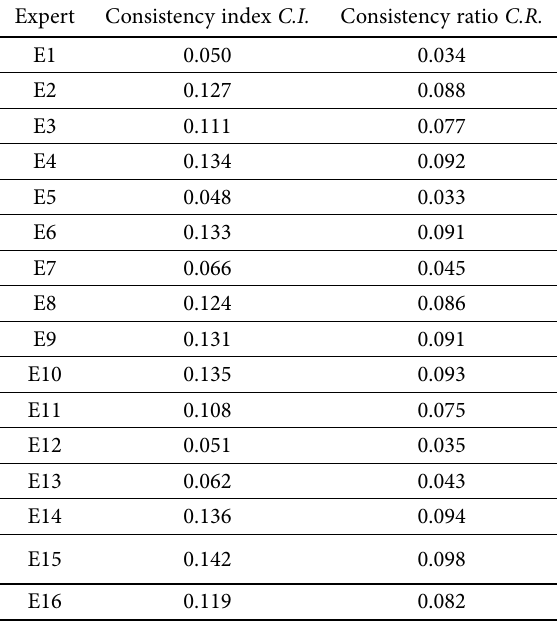
Table 4. The values of consistency indices and ratios referring to data on criterion evaluation provided by all experts Expert Consistency index